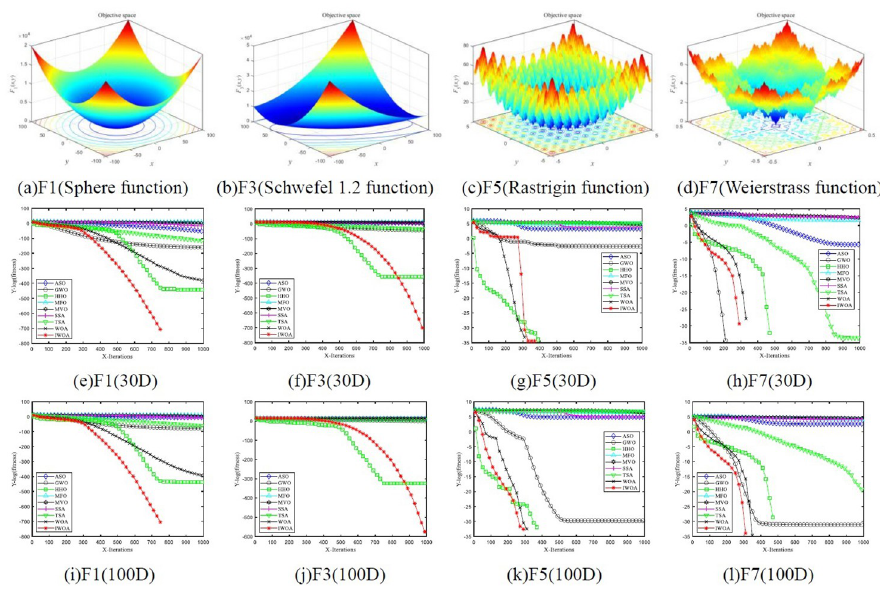
Fig 6. Logarithmic mean convergence curves of different algorithms. (a)F1(Sphere function), b)F3(Schwefel 1.2 function), (c)F5(Rastrigin function), d)F7(Weierstrass function), (e)F1(30D), (f)F3(30D), (g)F5(30D), (h)F7(30D). (i) F1(100D), (j)F3(100D), (k)F5(100D), (l)F7(100D).